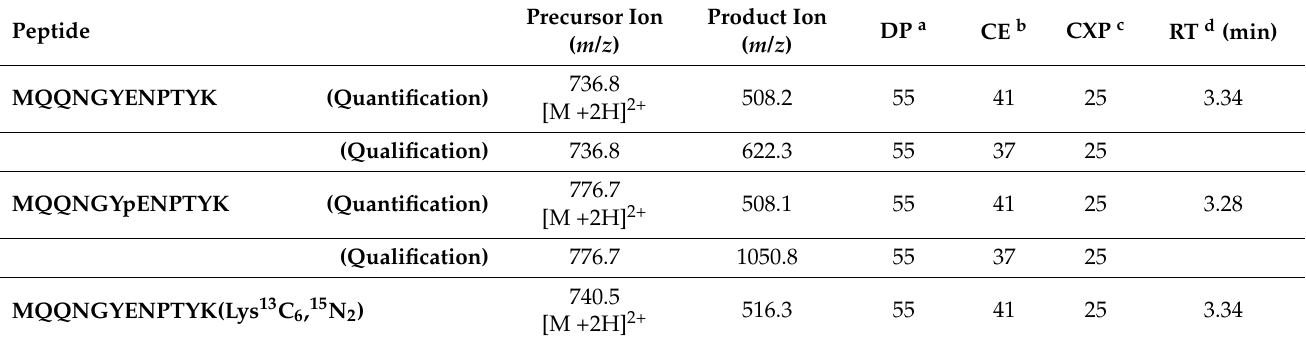
Table 1. Optimized Q1 mass, transitions, and parameters for MRM